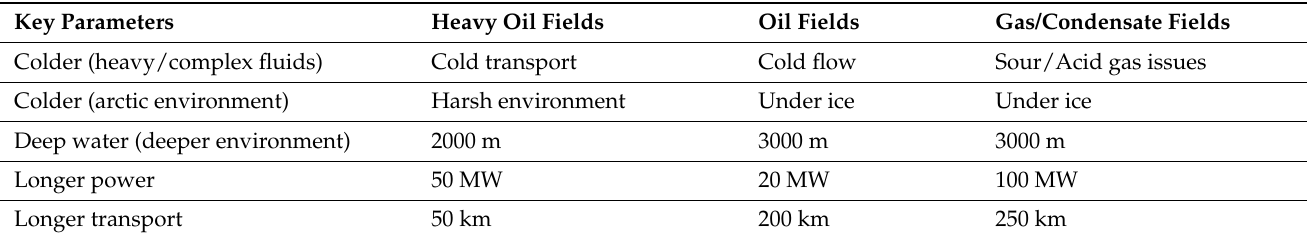
Figure 5. Subsea Production Systems in the Statoil Subsea Factory TM (Courtesy: Statoil). Table 2. Targeted ambitions for subsea